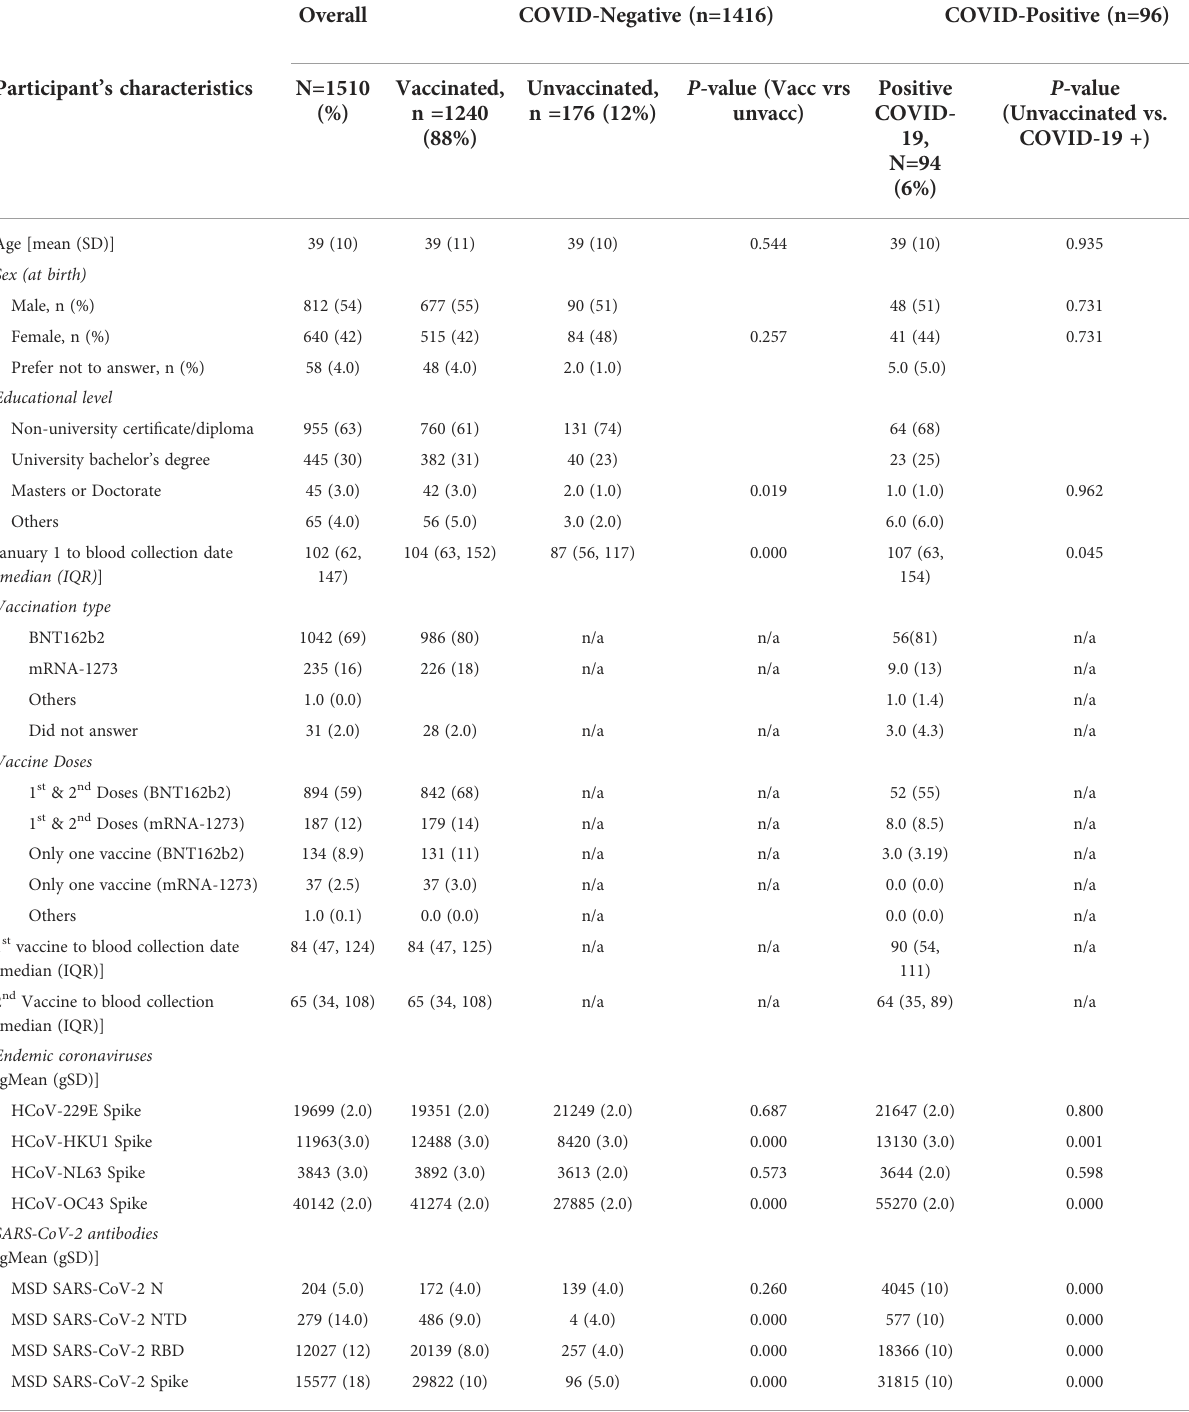
TABLE 1 Participant characteristics by vaccination